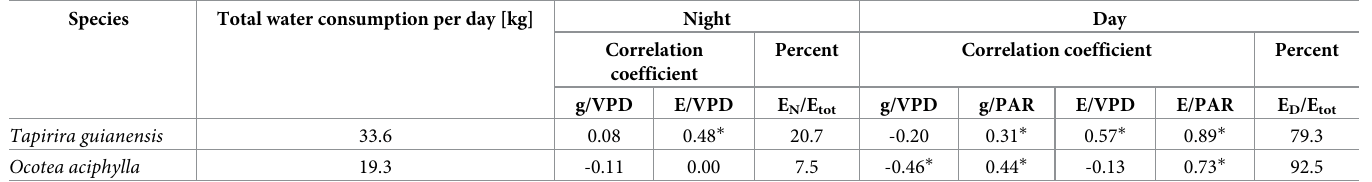
Table 3. Parameters characterizing leaf transpiration over two nights and two days of Tapirira and Ocotea as representatives of the two groups of differing hydro- logical performance. * p < 0.05. Species Total water consumption per day [kg] Night Day